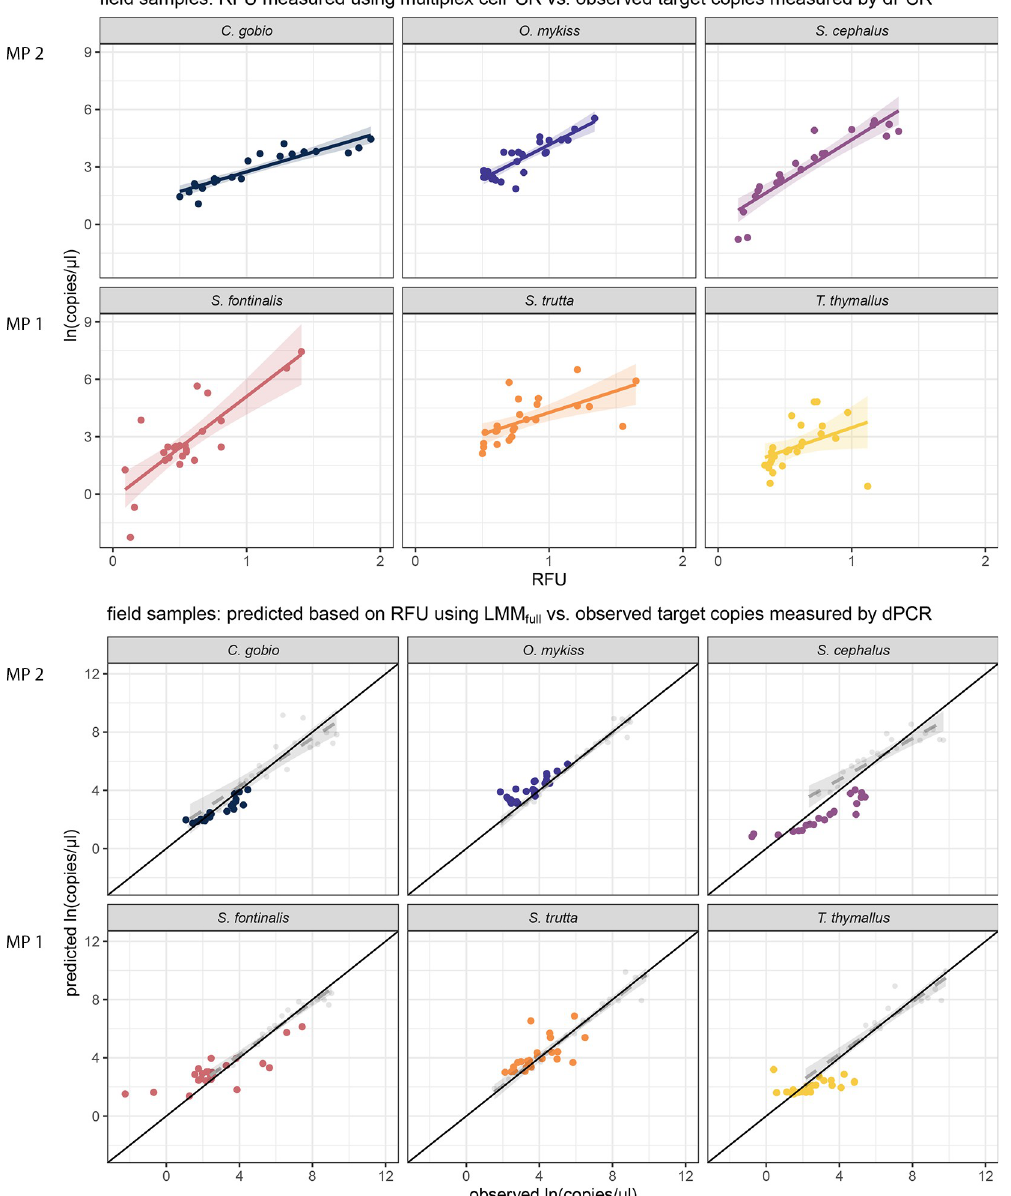
Fig 5. Multiplex celPCR and dPCR results and predicted vs. observed DNA concentrations for field-collected samples. The relationship between RFU and ln -transformed target DNA copy numbers measured in field-collected samples for each of the primer pairs is displayed in the upper panel; for details on the linear models and their 95%-CIs see S5 File. The relationship between target DNA copy numbers measured in field-collected samples in comparison to the predicted copy numbers based on LMM full is depicted in the lower panel. The black line (origin 0/0, slope 1) represents a perfect fit between observed and predicted copy numbers; the dashed regression line and the associated 95%-CIs are based on a comparison between measured and predicted copy numbers from the dilution series experiment based on LMM full and mean RFU per dilution step. For details on the linear models and 95%-CIs see S6 File.